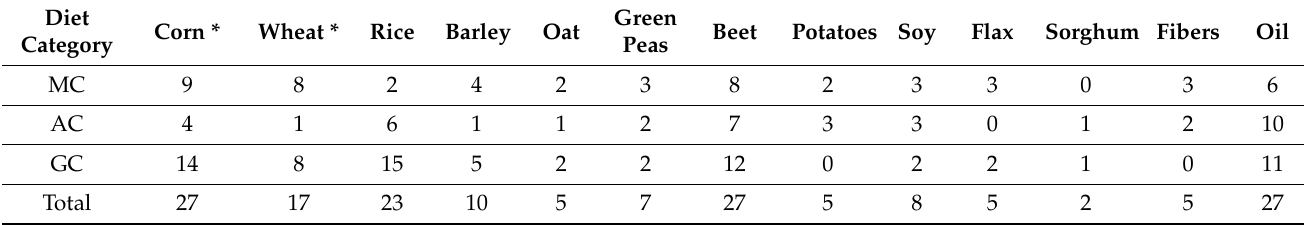
Table 2. The main ingredients of the studied dry dog food samples grouped by